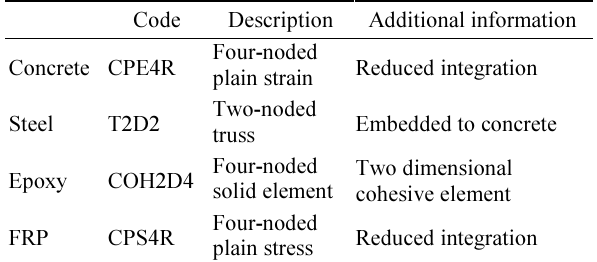
Table 5. Finite element types employed in numerical modeling